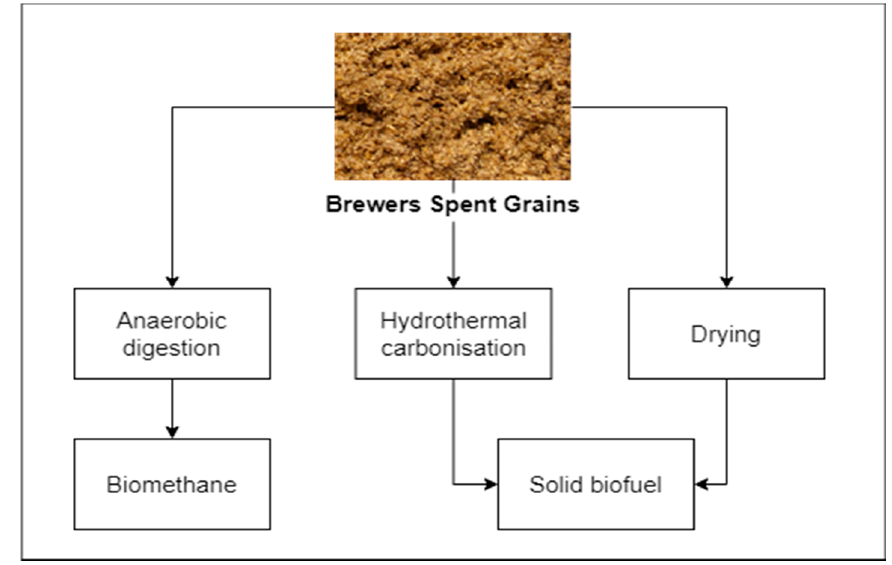
Figure 2. Energetic valorization of BSG.